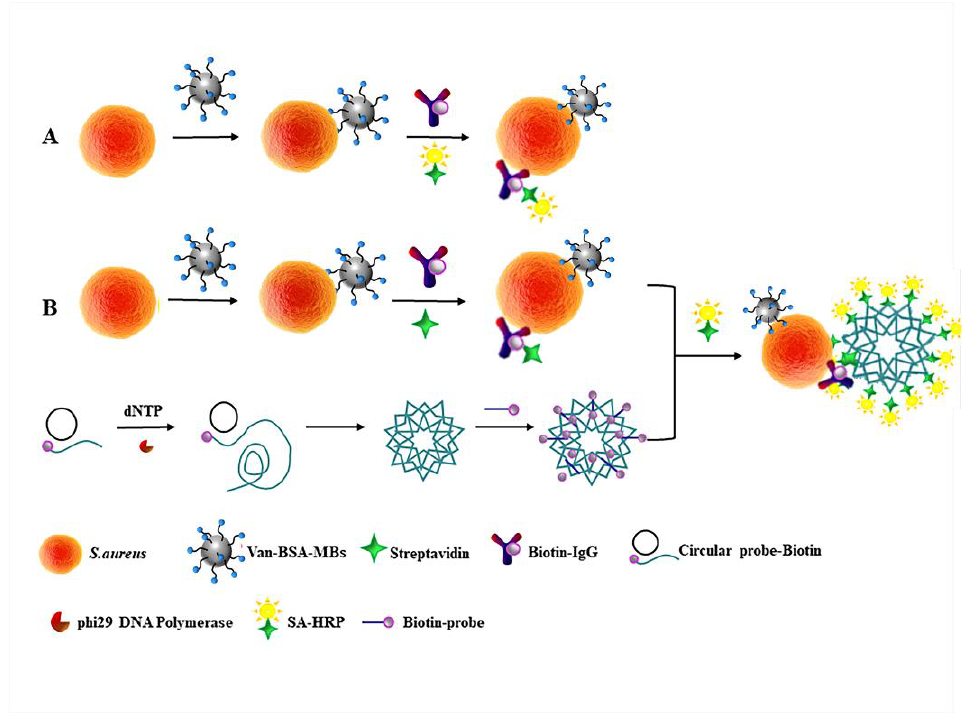
Scheme 1. The scheme of the AMS-DNFs detection method. ( A ) The antibiotic magnetic separation AMS-DNFs amplification colorimetric detection method and ( B ) common colorimetric detection method for S. aureus .